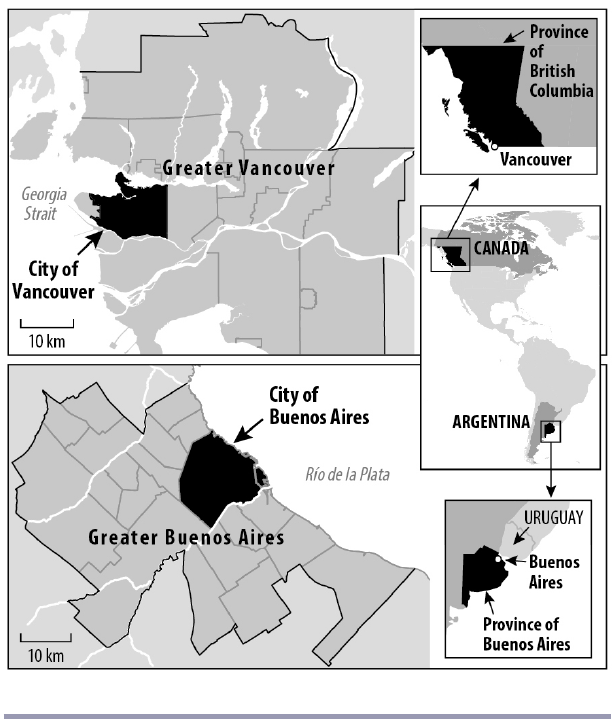
Fig. 1. Geographical locations of the two case